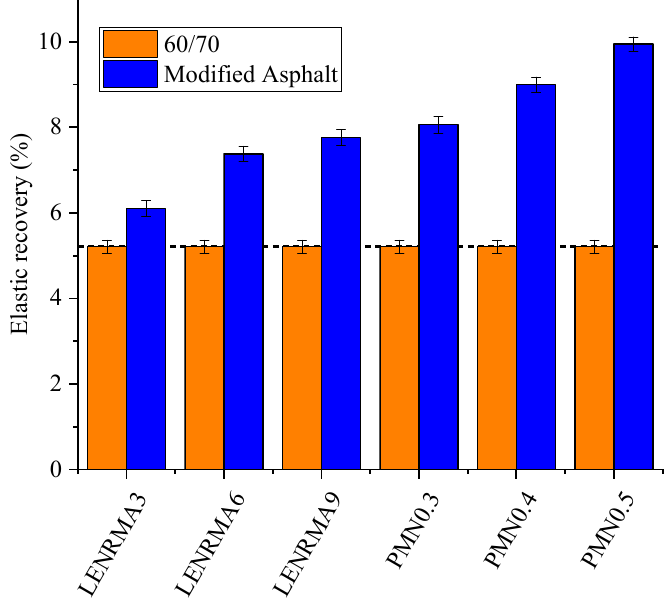
Figure 8. Elastic recovery test results of modified binders.